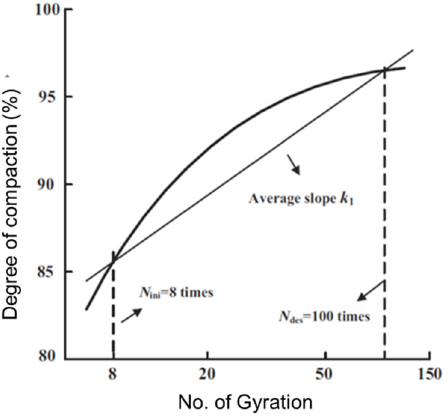
Figure 12. Illustration of the definition of average slope K 1 from the compaction curve of the degree of compaction versus the number of gyrations [46].